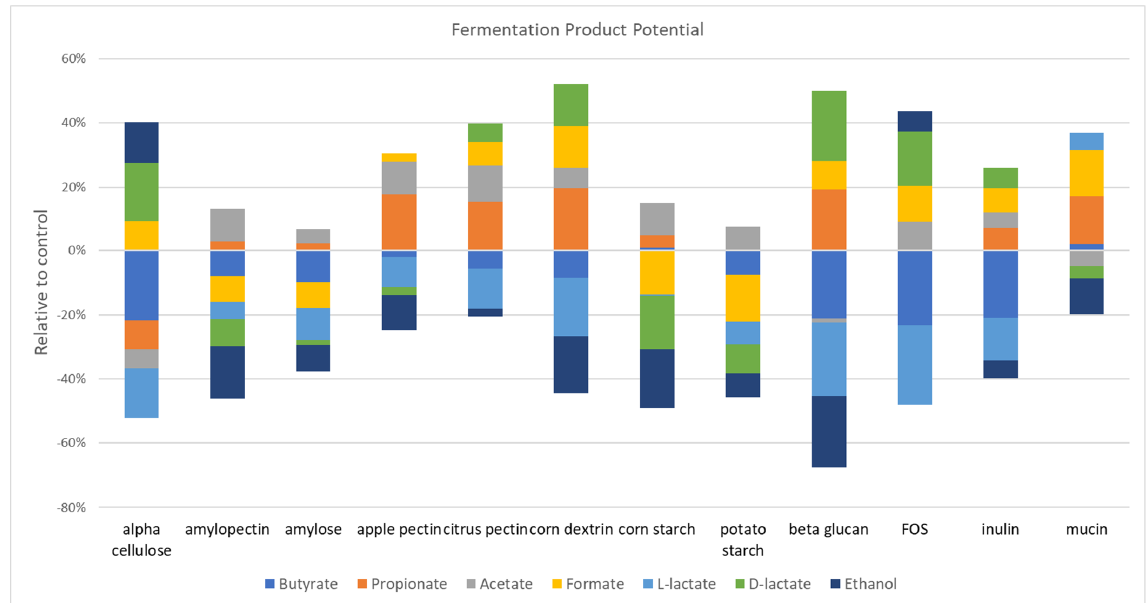
Figure 4. Prebiotic supplementation alters the representation of SCFA biosynthetic capacity. The impact of the relative abundance of communities stimulated with prebiotics on the predicted capacity to synthesize SCFAs and products of fermentation (colored bars).